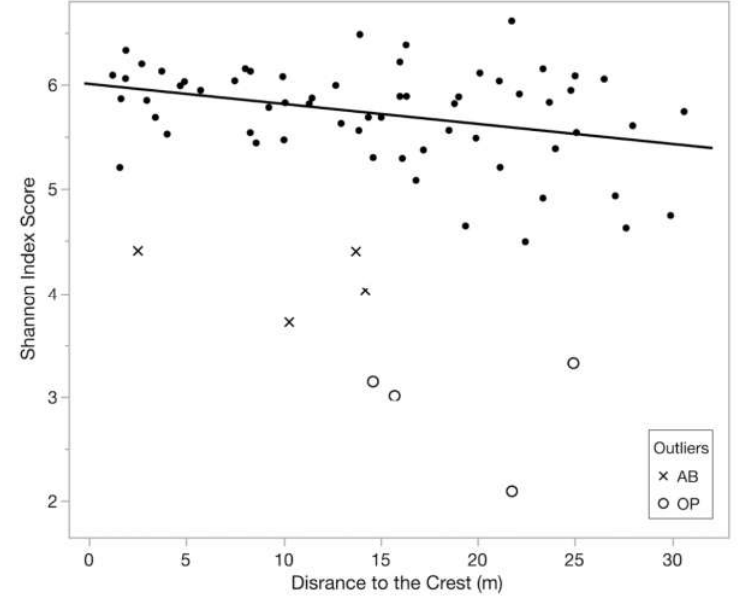
Figure 8. OTU diversity decreases moving inland from the crest. This relationship is a trend including eight highlighted outliers and significant with them removed. The eight outliers are explicitly from A. breviligulata stands (AB) and blowout (OP) microhabitats.